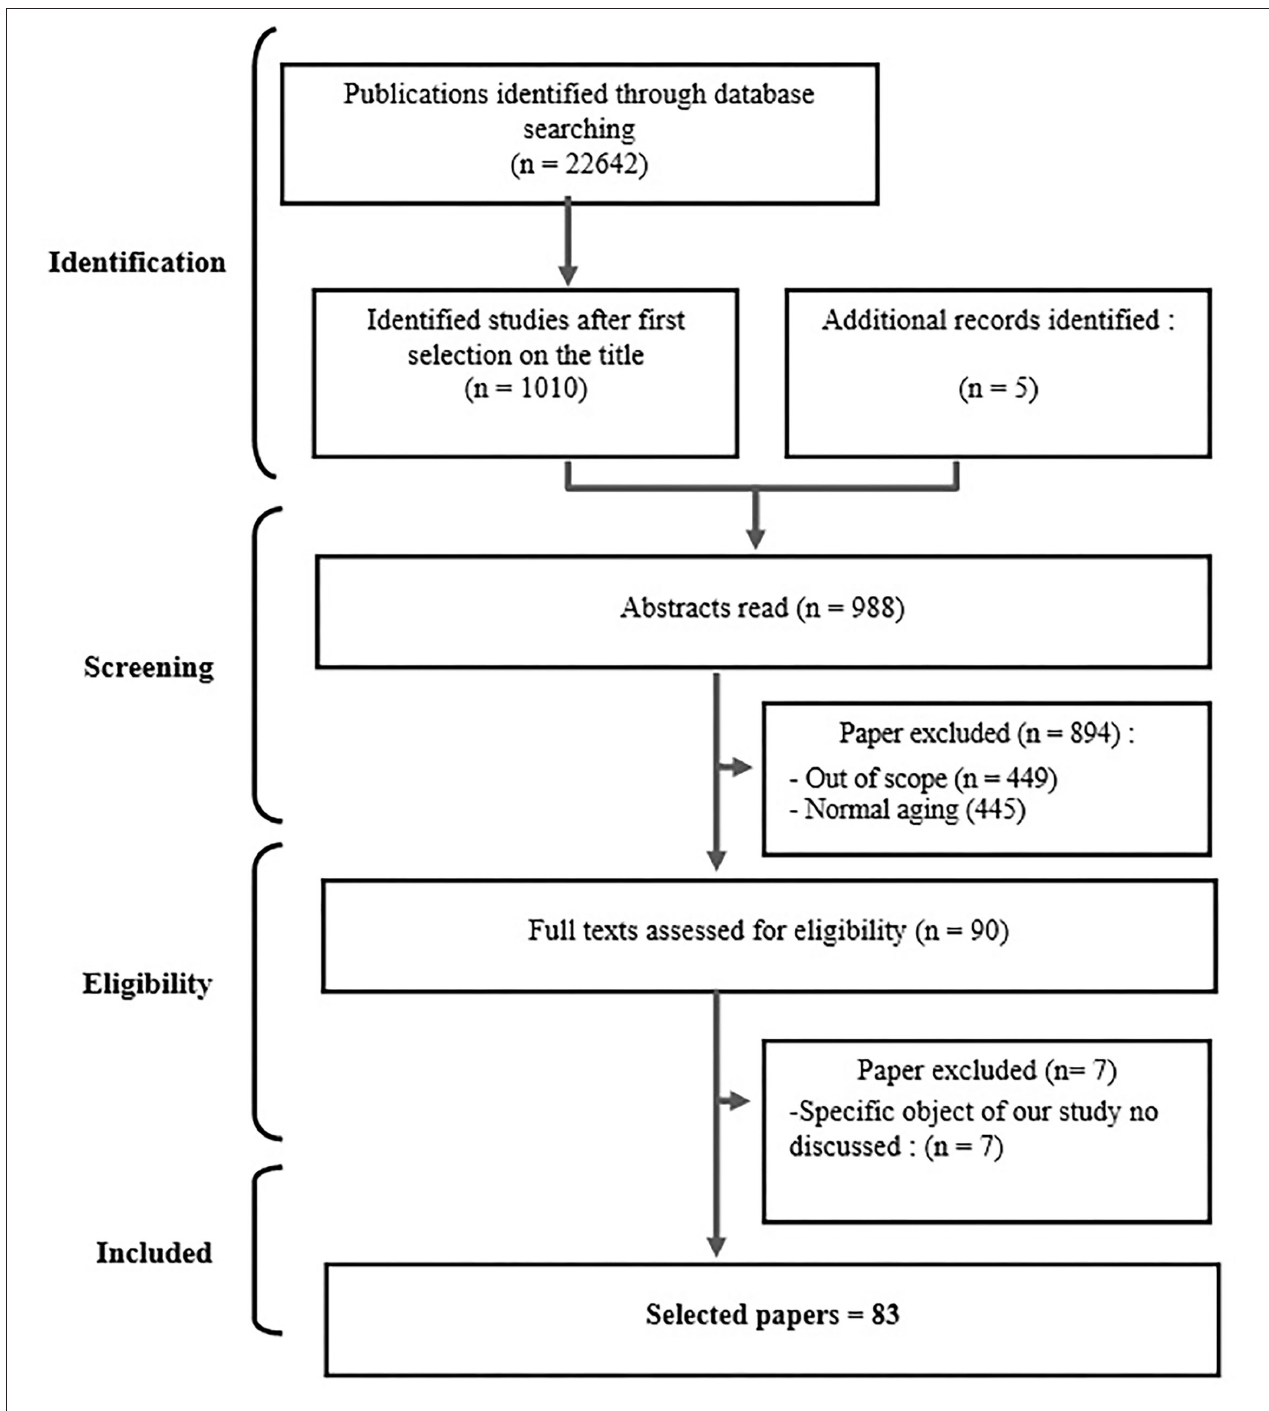
FIGURE 1 | Flow diagram of the selection